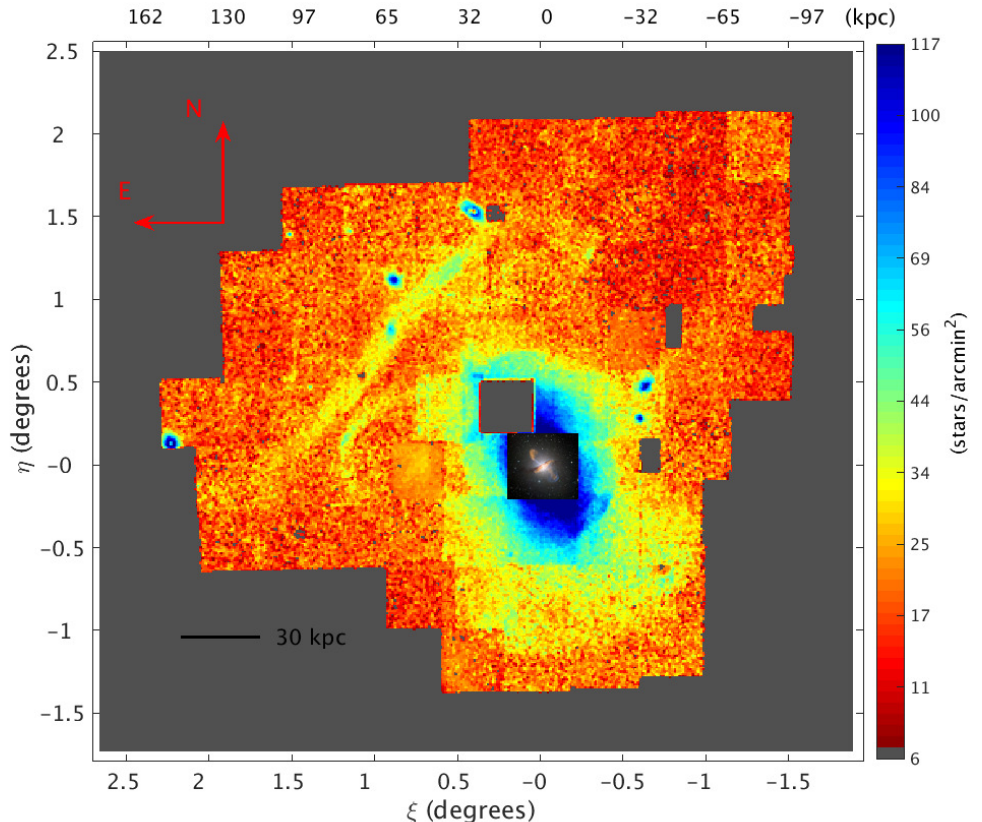
Figure 1. Stellar density map of old, metal-poor RGB stars in the extended halo of Cen A, from the Magellan/Megacam PISCeS survey (Figure 3 from [11]). PISCeS reaches significantly fainter surface brightness limits (down to µ V ∼ 32 mag/arcsec 2 ) with respect to integrated light alone, thus allowing us to decode the past evolutionary history of Cen A. The density scale is shown on the right; the physical scale is reported on the upper axis. The central regions of the galaxy are replaced by a color image (the star-count map in this region suffers from incompleteness due to stellar crowding). The next generation of telescopes will allow us to obtain comparable maps for tens of galaxies in the Local Volume, thus revolutionizing our understanding of galaxy